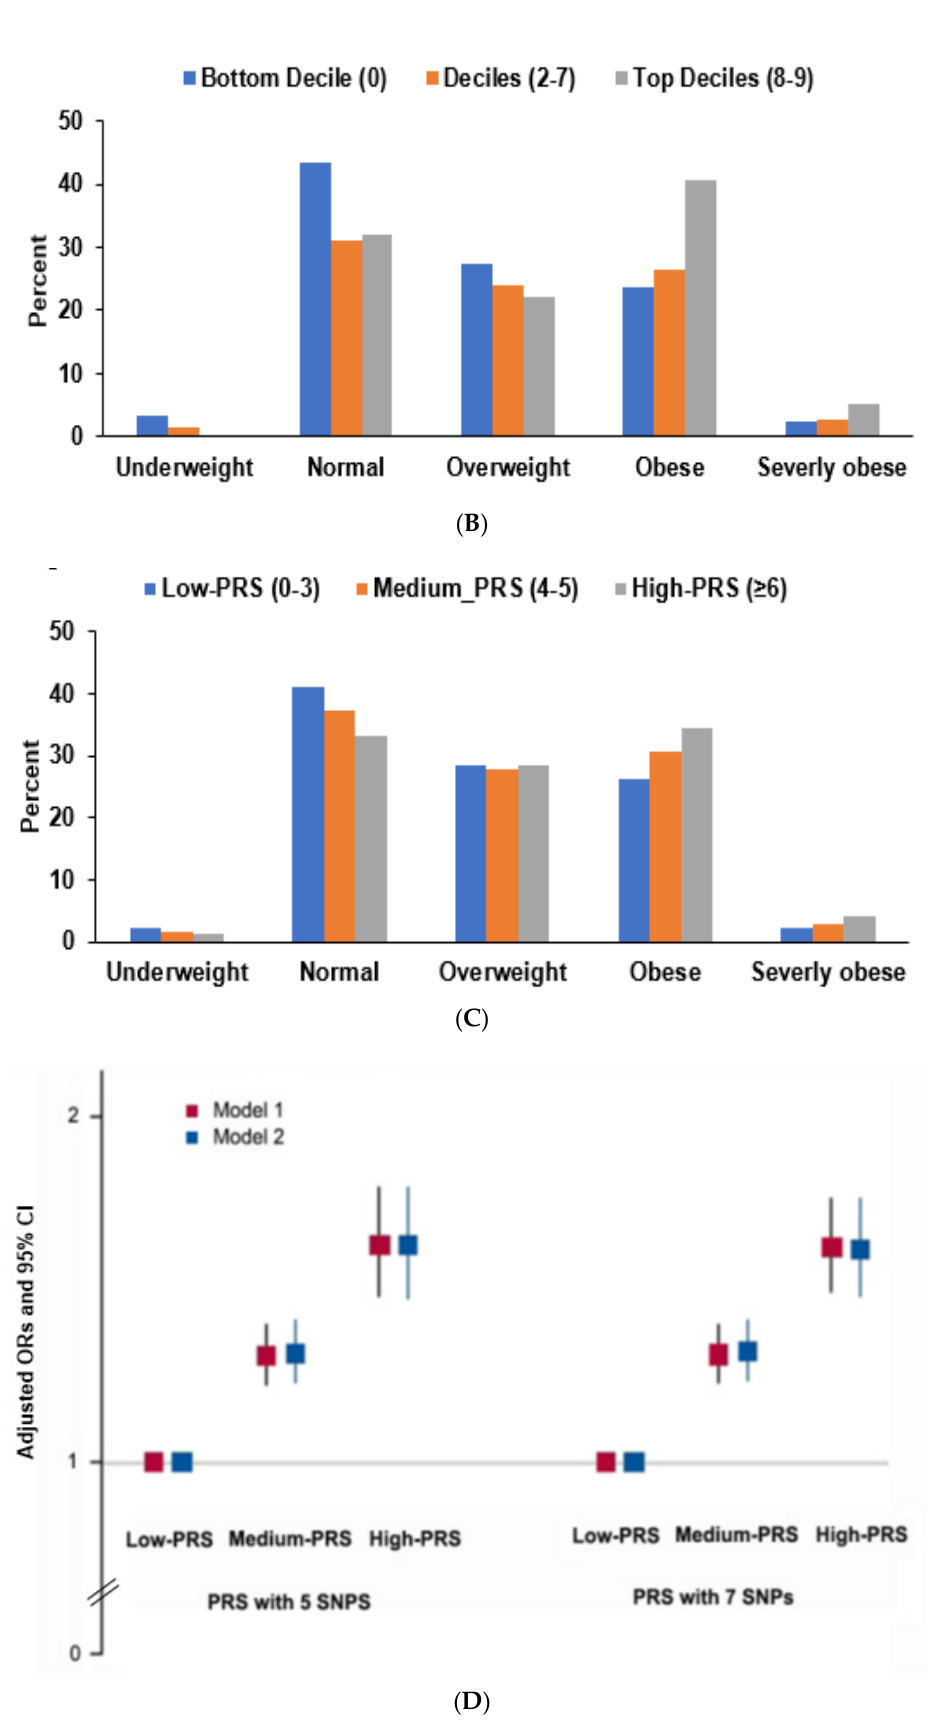
Figure 2. Relationship of polygenetic risk scores (PRS) to obesity risk: ( A ) BMI of participants according to 10 deciles of